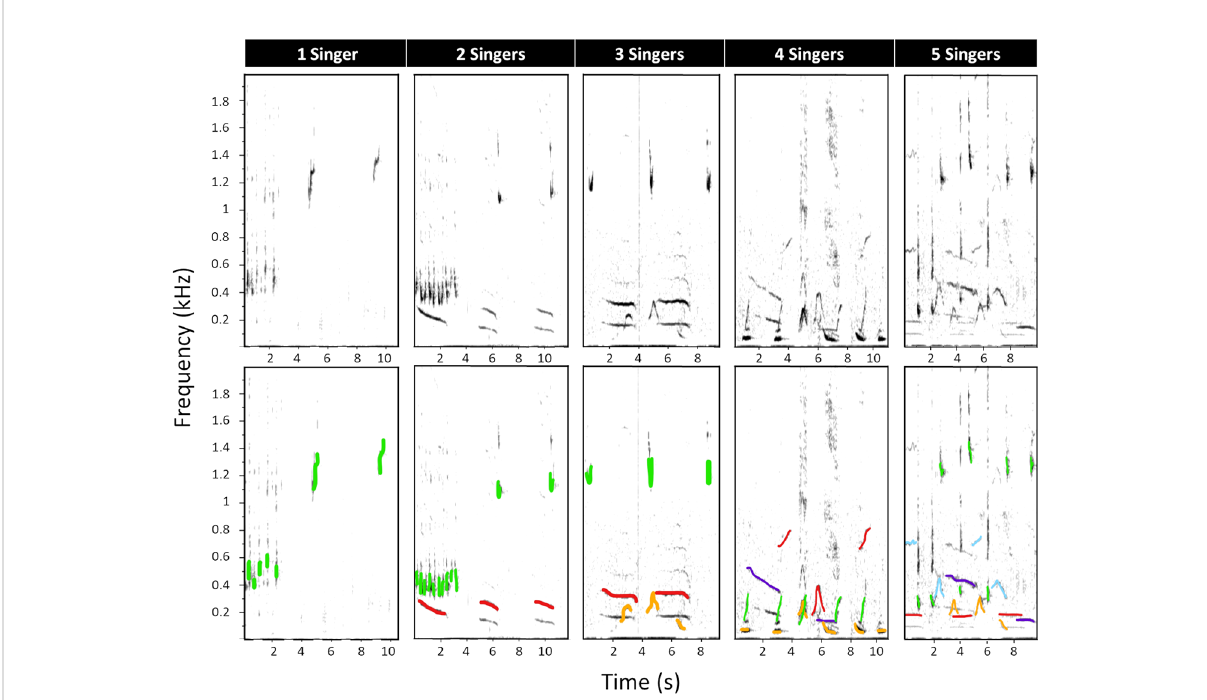
FIGURE 2 Spectrograms of multiple humpback whales signing, showing fi ve different recordings that vary in their number of simultaneously singing humpback whales. In the lower panel, every singer has been allocated a colour to visualise overlapping units and/or overlapping phrases. Only the fundamental units were coloured. Differences in sound intensity can be seen in the upper panel by the darkness of a unit. Spectrogram parameters: fast Fourier transform (FFT) size = 2048 points, overlap = 75%, sample rate = 16000 Hz, frequency resolution = 7.8 Hz and time resolution = 32